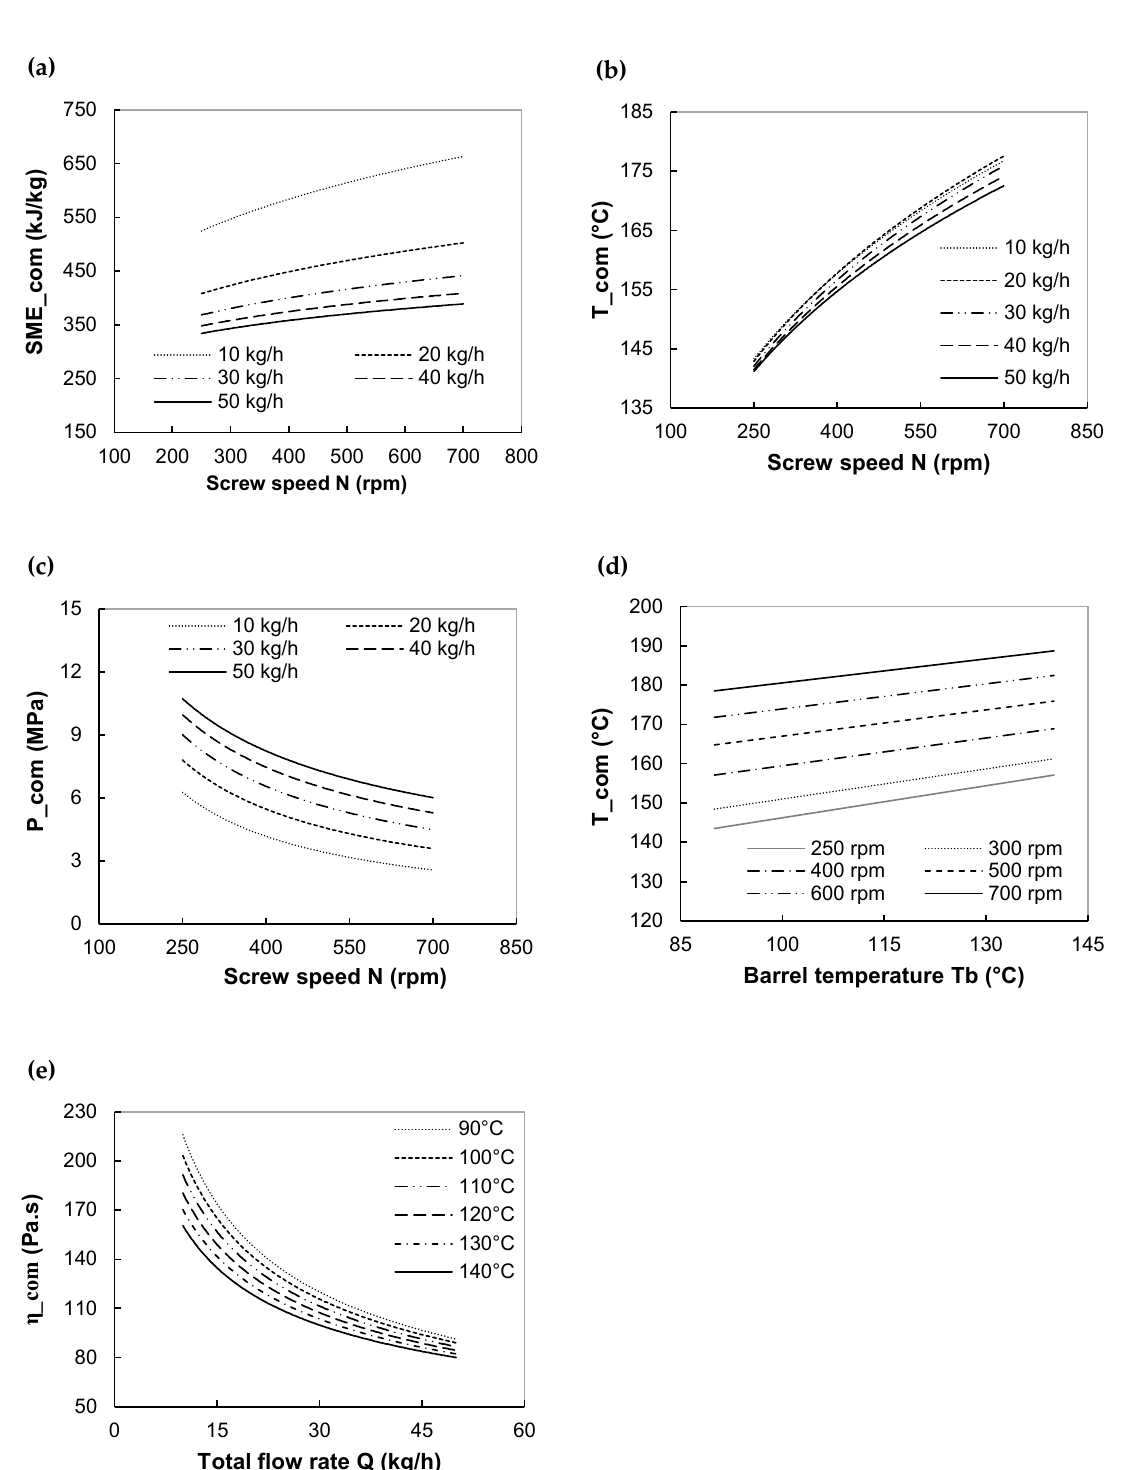
Figure 4. Sensitivity study of the effect of extrusion operating conditions on predicted flow variables for breakfast cereals. HB recipe, MC = 19%. ( a ) variation of SME_com, ( b ) melt temperature at die exit T_com and ( c ) die entrance pressure P_com with screw speed N for various flow rates Q. Last barrel temperature Tb = 90 ◦ C, ( d ) variation of T_com with Tb for various screw speeds N. Q = 20 kg/h, ( e ) variation of viscosity η _com with Q for various Tb. N = 500